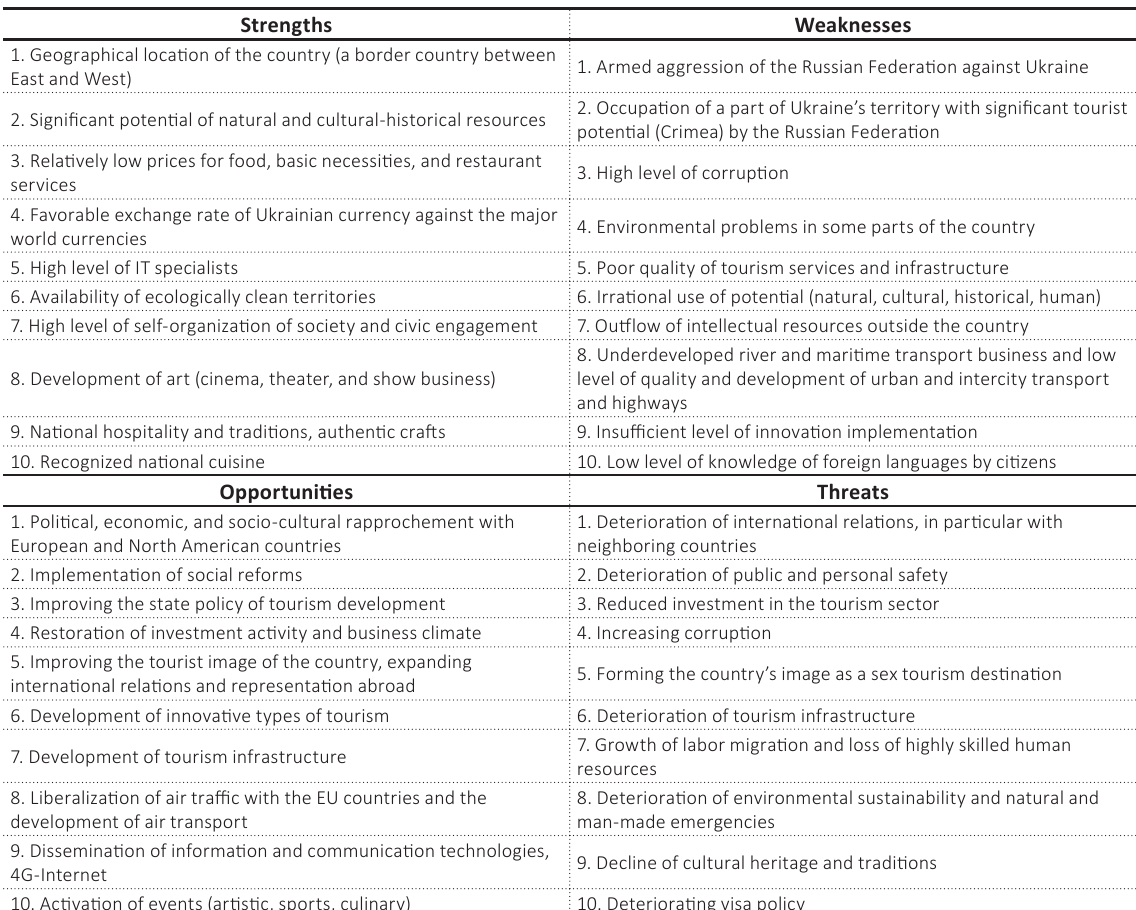
Source: Developed by the